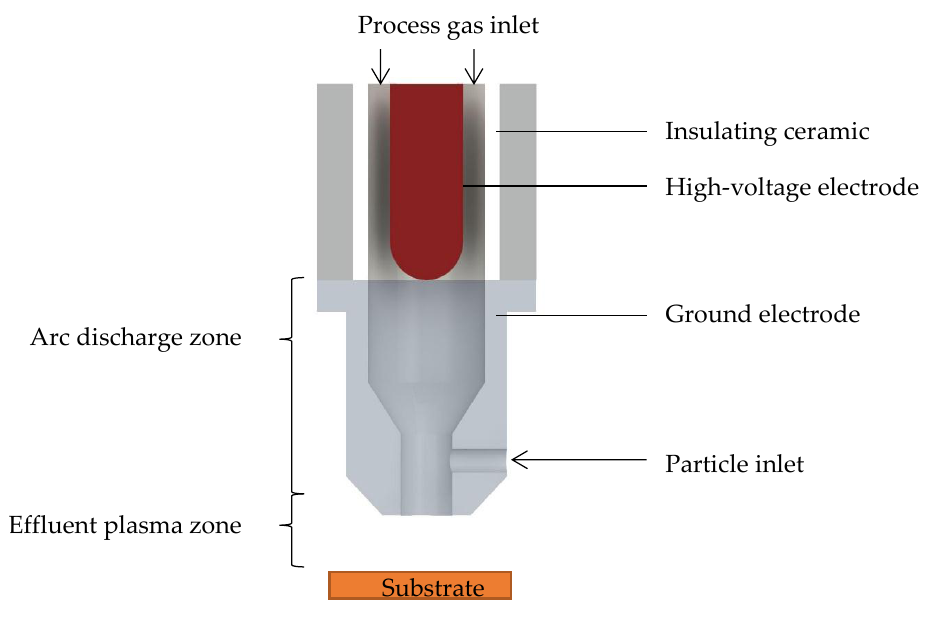
Figure 1. Cross-section of the electrode setup with particle inlet.